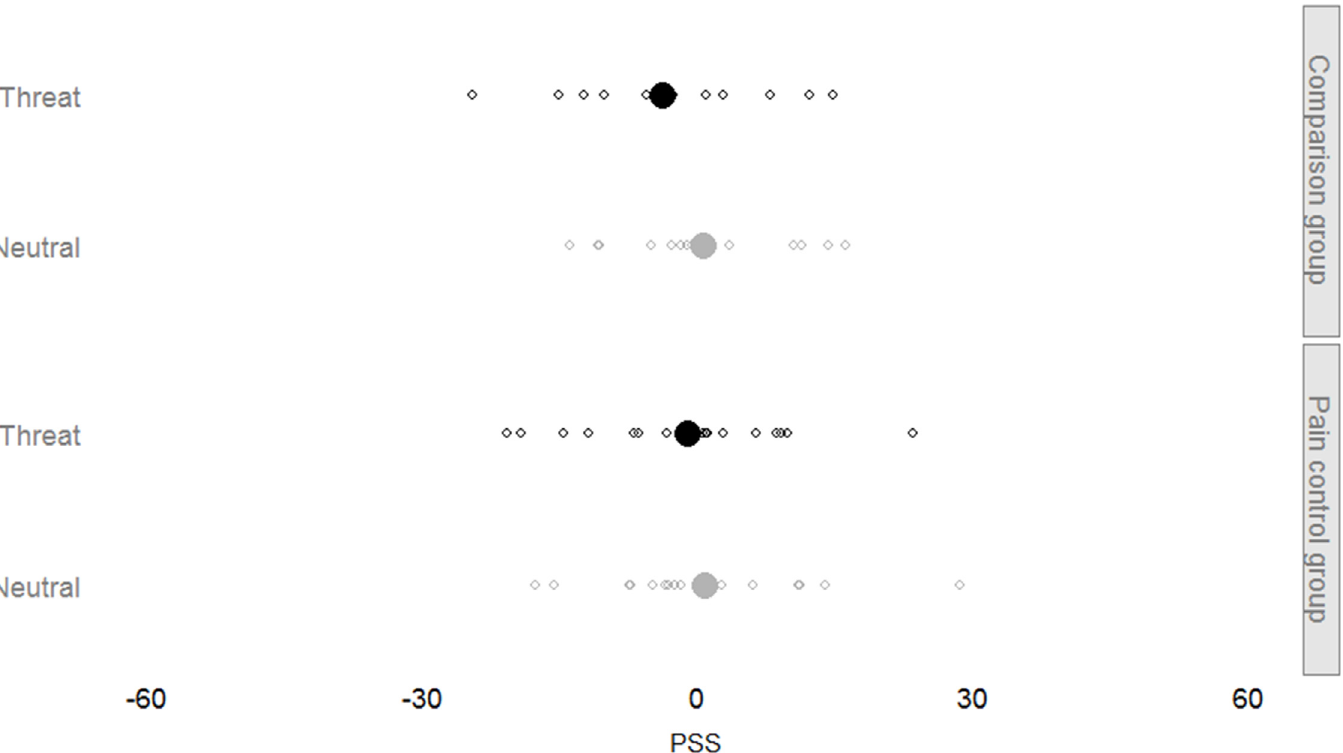
Fig 2. Peak PSS overview. We compared individual Point of Subjective Simultaneity (PSS) measurements across conditions. For every participant in both the comparison group and the pain control group, we calculated the peak PSS (smaller, hollow circles). Mean PSS values are indicated as well (larger, solid circles). PSS values based on threat trials are black, whereas PSS values based on neutral trials are grey. More positive values means somatosensory information from the threatened body location is processed quicker than somatosensory information from the other hand. The illustrated pattern shows no clear bias towards either stimulus, neither due to the threat manipulation or the goal